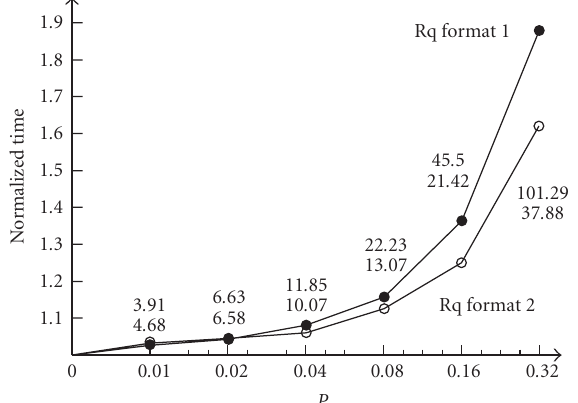
Figure 11: Normalized duration of transfer versus packet error rate under “random loss” conditions.